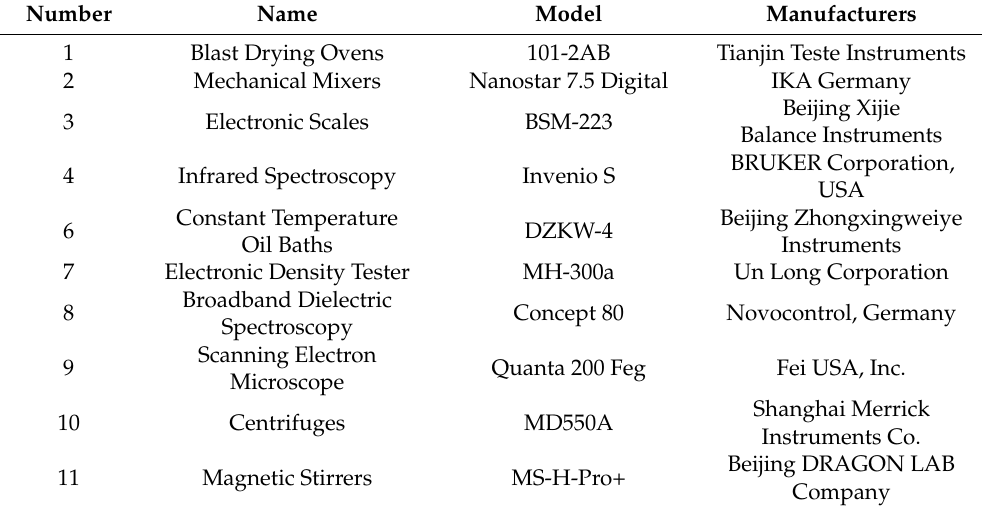
Table 2. Experimental apparatus.